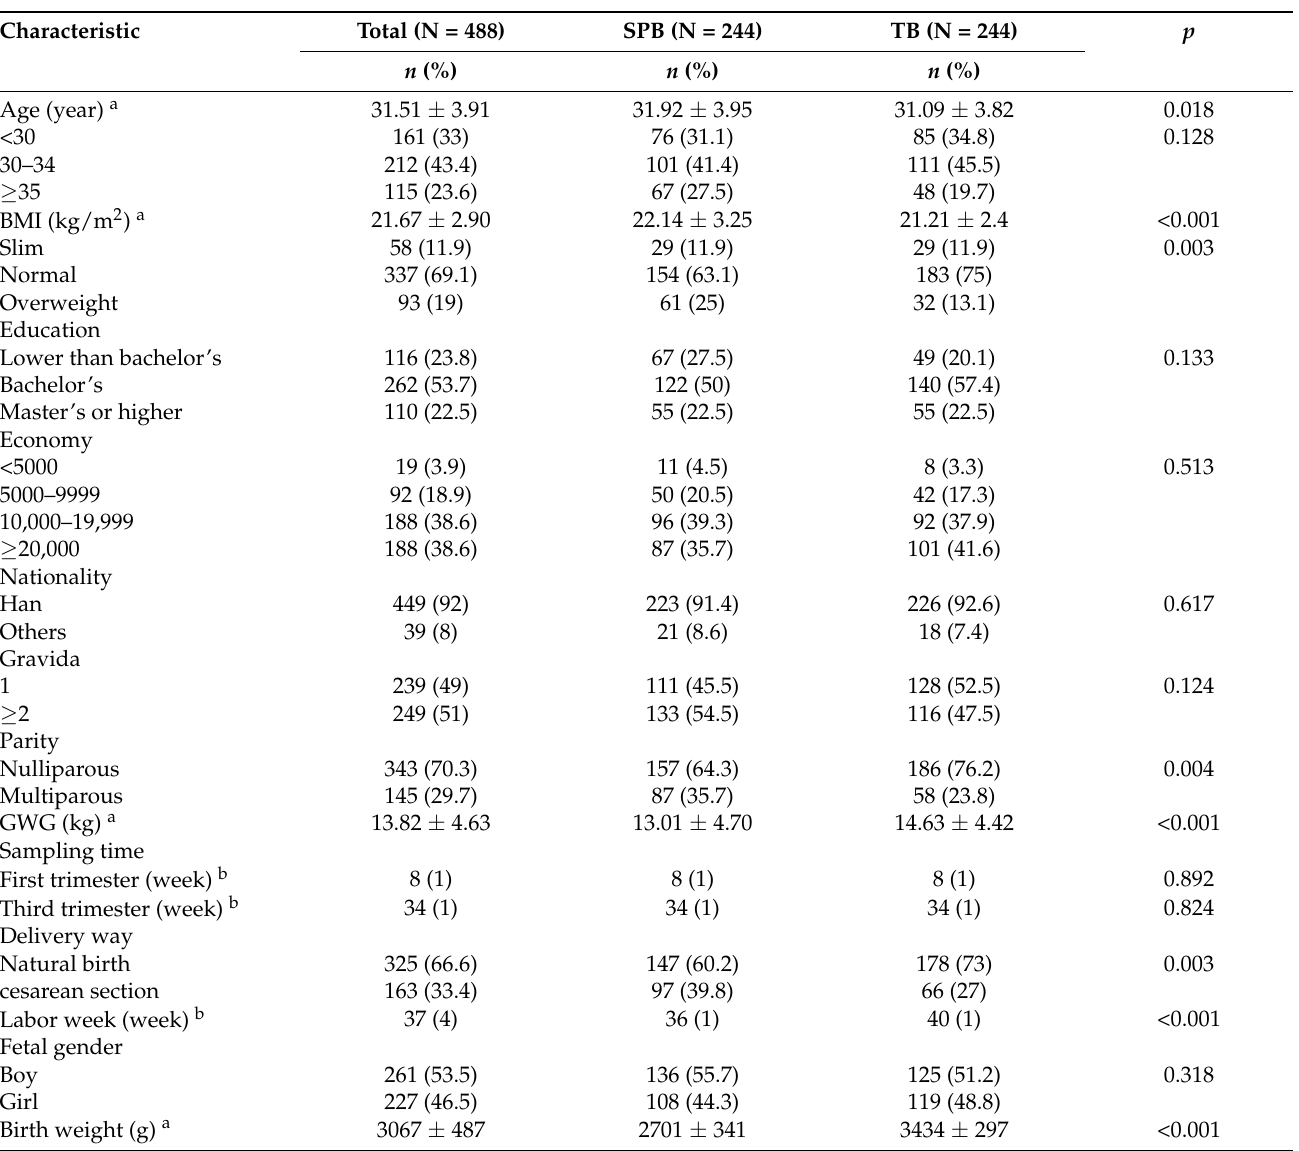
Table 1. Characteristics of